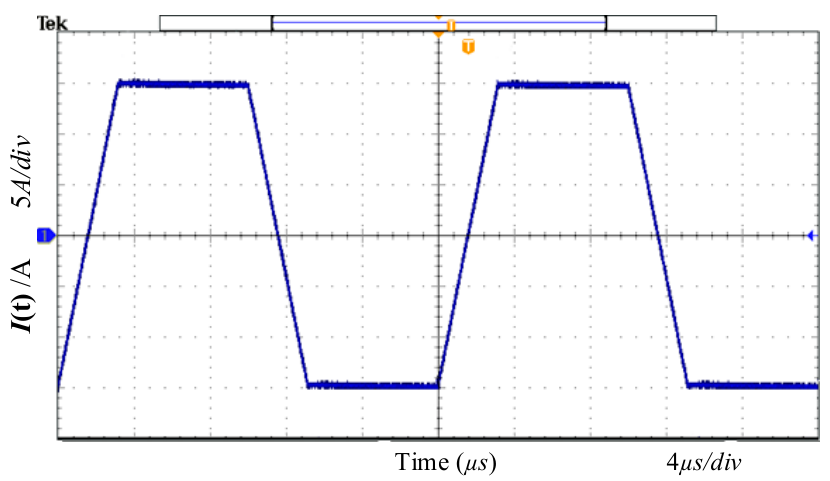
Figure 12. Experimental voltage waveform.